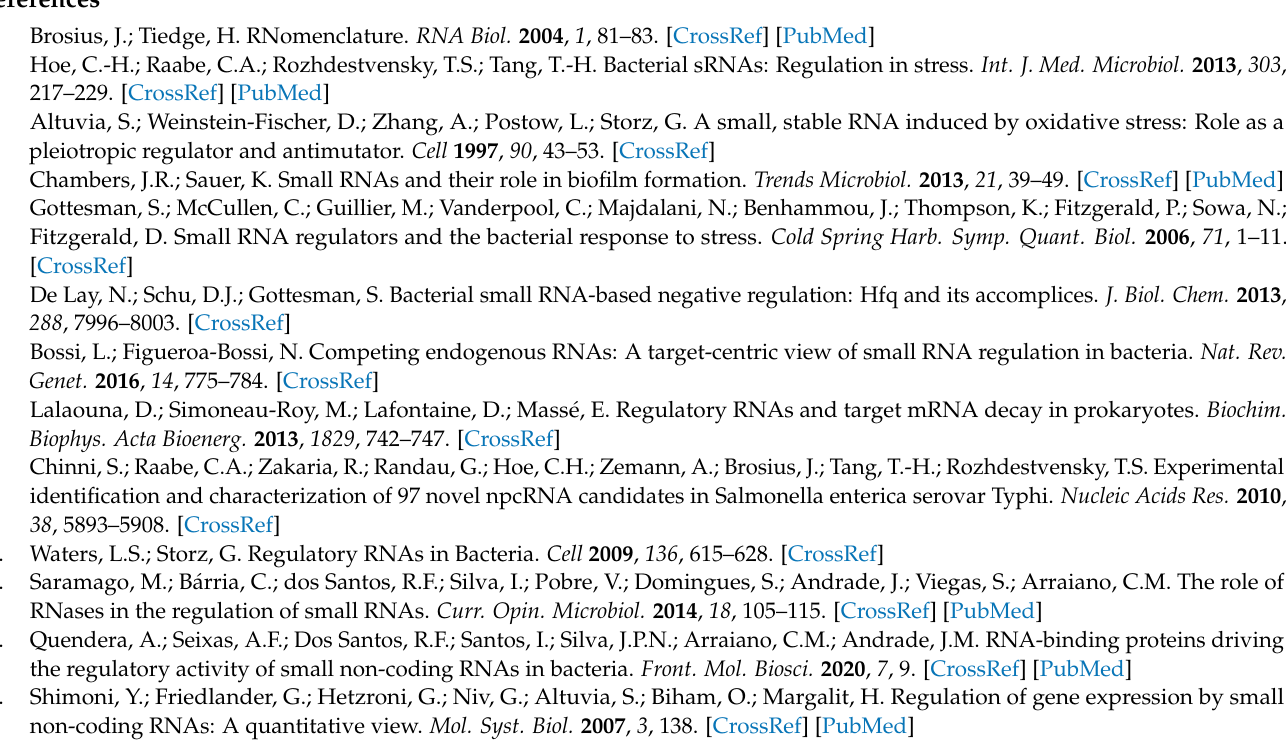
ulations., Figure S2. Protein and RNA RMSD of the Ads(N48A) system from three simulations, Figure S3. Protein and RNA RMSD of the Aus system from three simulations, Figure S4. Protein and RNA RMSD of the Aus(N48A) system from three simulations, Figure S5. The RMSF of gas phase interaction energy of 10-ns sliding window in the last 50 ns for Ads and Ads(N48A) systems. The x-axis represents the start time of a 10-ns window. The windows with the smallest RMSF are marked with triangles, Figure S6. The RMSF of gas phase interaction energy of 10-ns sliding window in the last 50 ns for Aus and Aus(N48A) systems. The x-axis represents the start time of a 10-ns window. The windows with the smallest RMSF are marked with triangles, Figure S7. Time-averaged interaction entropy of continuous 10 ns with lowest energy fluctuation of for Ads and Ads(N48A) systems under three simulations, Figure S8. Time-averaged interaction entropy of continuous 10 ns with lowest energy fluctuation of for Aus and Aus(N48A) systems under three